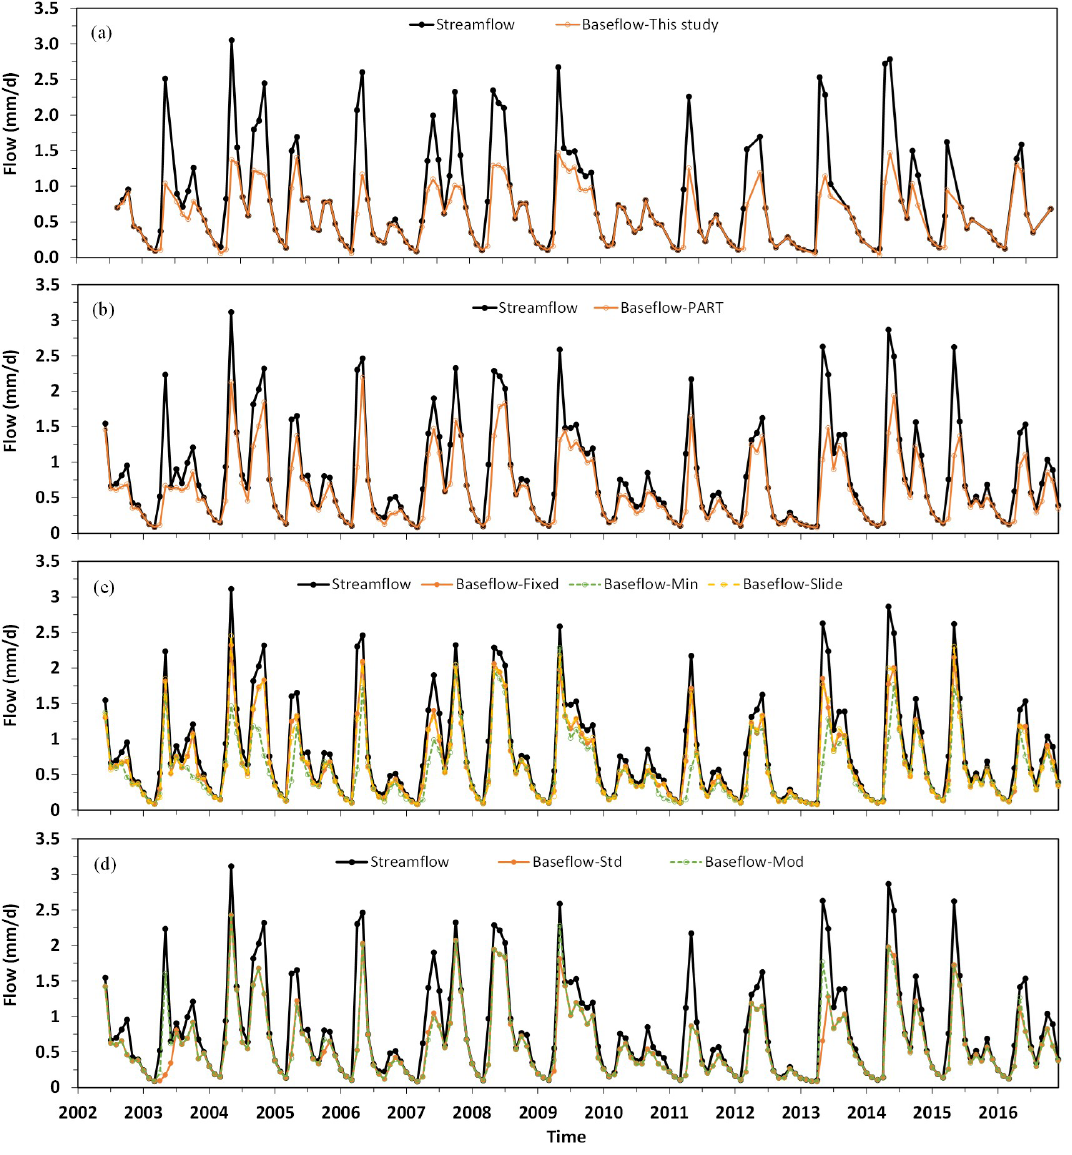
Figure 8. Hydrograph separation of the Albany River for 2002–2016. Data shown are monthly values for the observed total streamflow (black line/dot in each panel) and the baseflow estimated by the methods of (a) this study, (b) PART, (c) HYSEP, including Fixed Interval, Sliding Interval, and Local Minimum, and (d) BFI, including Standard and Modified. Note that the months in (a) were based on GRACE monthly data temporal coverage (see Fig. 6), which varied over the years and were slightly different from the calendar months used for the other models shown in (b) , (c) and (d)